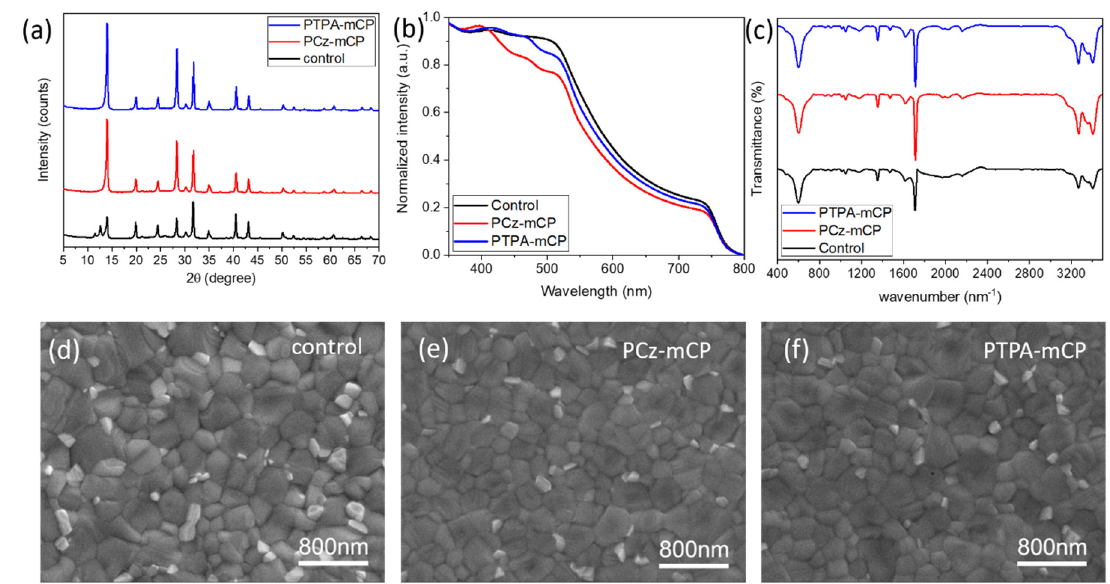
Figure 2. ( a ) XRD pattern of PCz-mCP and PTPA-mCP modified perovskite films; ( b ) normalized UV-vis curve and ( c ) FTIR spectra of control and modified perovskite film with PCz-mCP and PTPA-mCP; top-view SEM images of perovskite films: ( d ) control, ( e ) PCz-mCP, and ( f ) PTPA-mCP modified films.